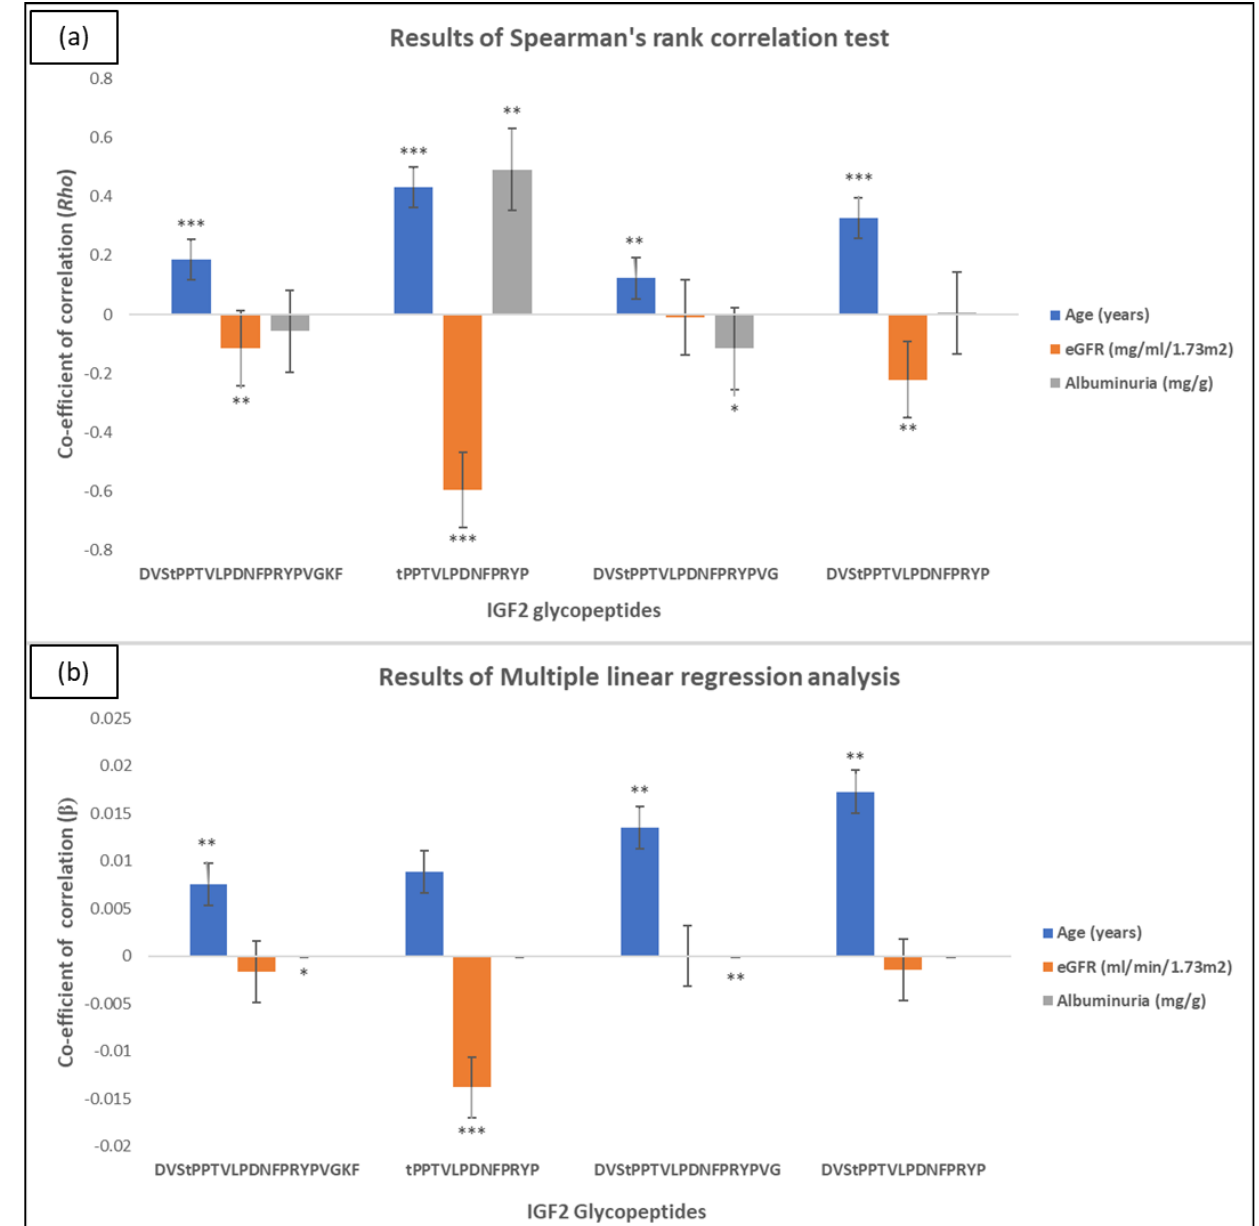
Figure 4. Results of ( a ) Spearman’s rank correlation test, ( b ) Multiple linear regression analysis for the abundance of four urinary IGF2 glycopeptides and Age, eGFR and Albuminuria. The statistically significant correlations are marked with asterisks (* p < 0.05, ** p < 0.0001, *** p <